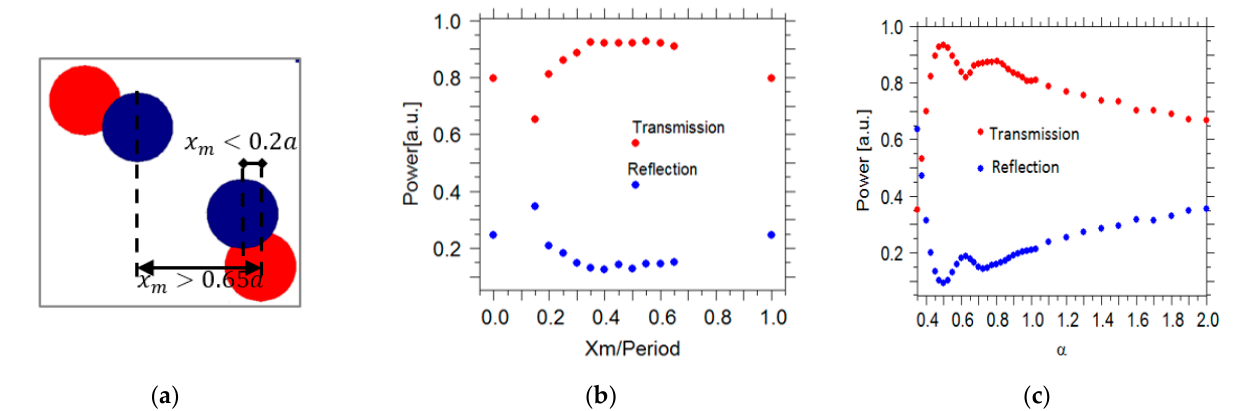
Figure 5. ( a ) A Schematic illustration to show how Si rods in the extra column (dark blue circle) overlap with Si rods (red circle) of the lattice. Transmission (red dots) and reflection (blue dots) ( b ): as function of x m for α = 0.5 ( c ) as function of α , for PCWG with R d = 0.06 a respectively.